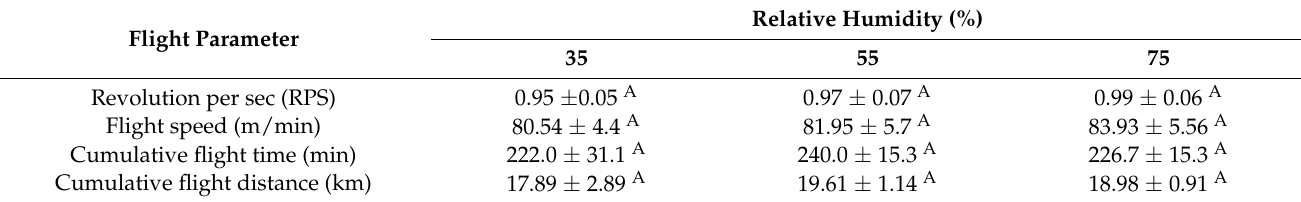
Figures with the same letter horizontally for each parameter are non-significant at alpha values of